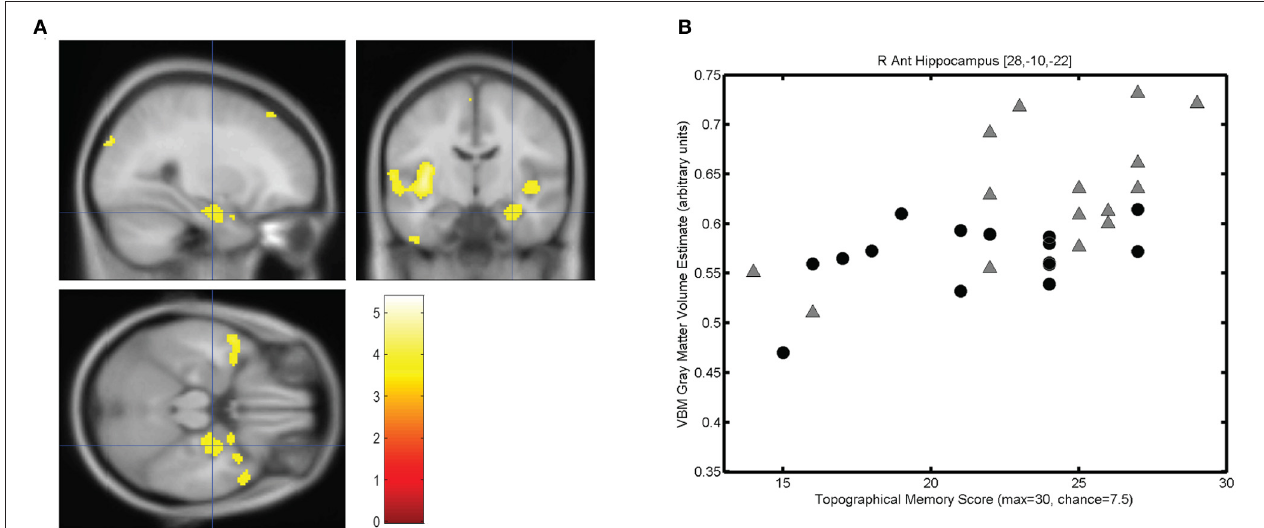
FIGURE 2 | Correlation between individuals’ hippocampal gray matter volume and topographical memory scores. (A) Regions showing a significant correlation between VBM gray matter volume estimate and score on the 30 item Four Mountains Task. Sagittal, coronal, and axial slices are centered on the peak voxel in the right hippocampus (28, − 10, − 22). Regions